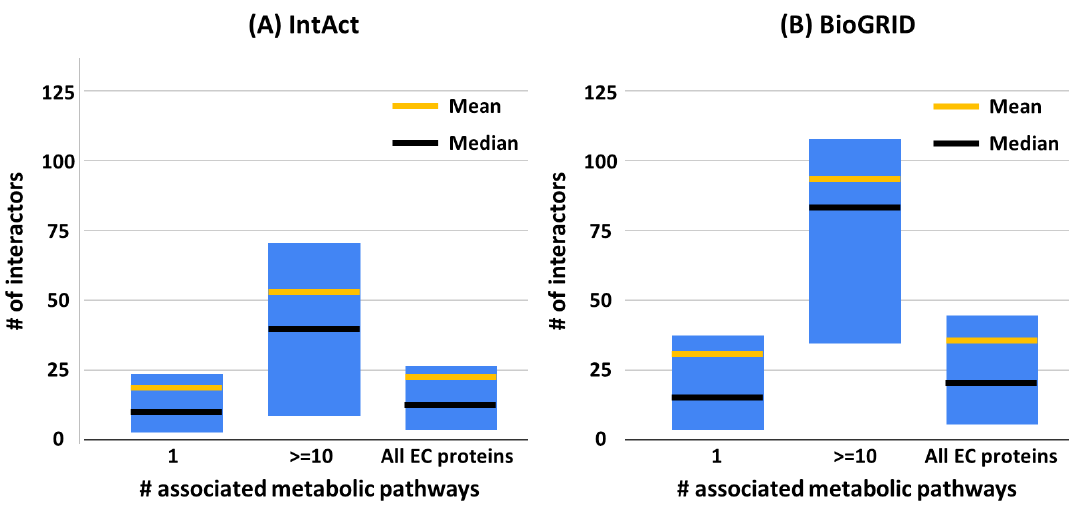
Figure 3. Statistical characterization of the number of interactors in EC proteins associated with human metabolic pathways. For each set, the boxes represent the first and third quartiles; yellow and black lines represent mean and median values, respectively. ( A ) and ( B ): from IntAct [14] and BioGRID [15], respectively. Significance of the reported differences on median values has been validated with the Mann–Whitney U test, obtaining p -value < 0.0001 when comparing the EC proteins with at least 10 interactors with the other two classes, for both IntAct and BioGRID databases. # Number of.